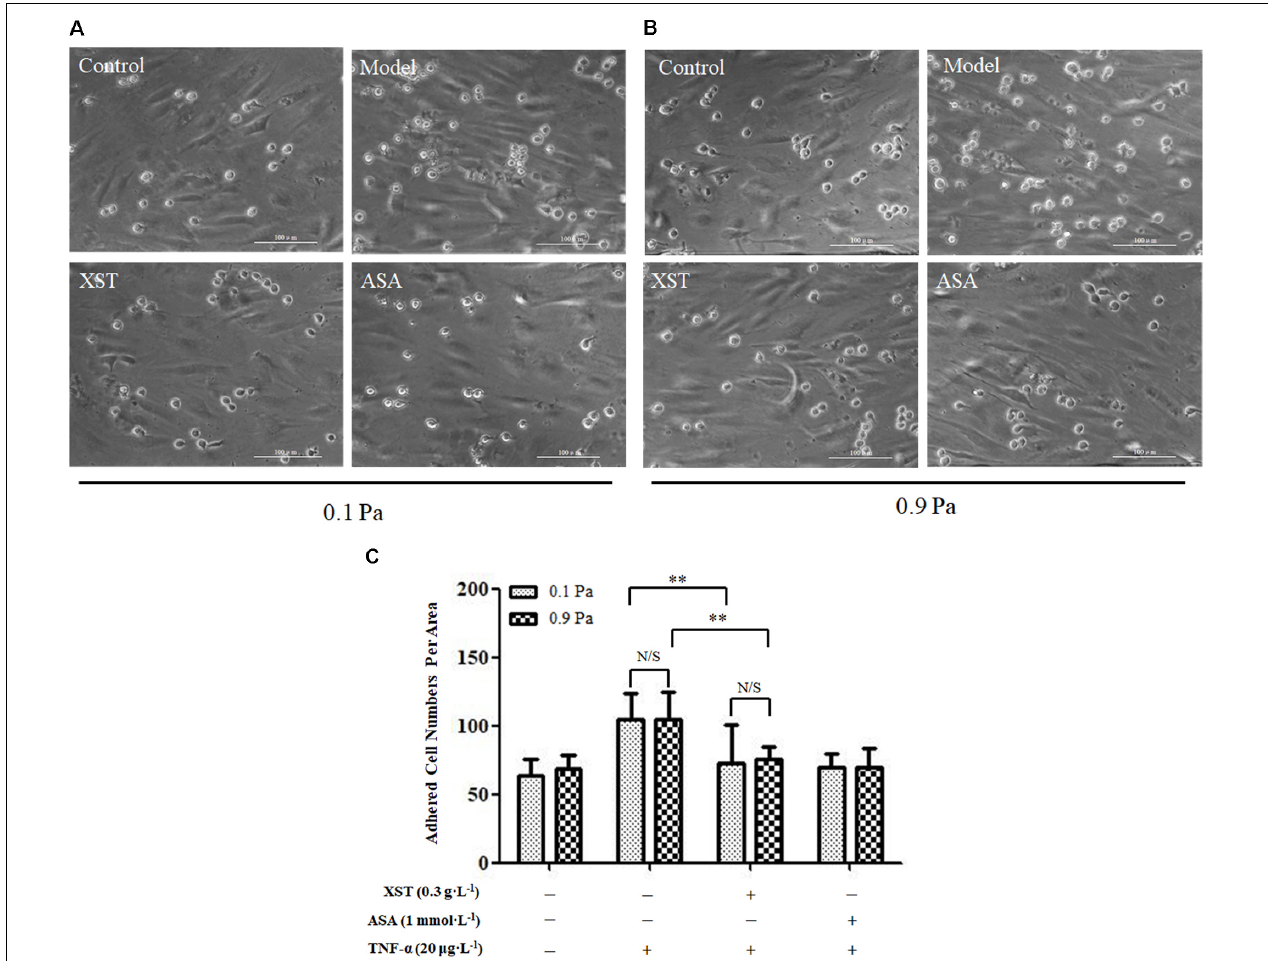
FIGURE 4 | Comparisons of THP-1 adhesion between groups. (A) under 0.1 Pa flow condition, and (B) under 0.9 Pa flow condition (magnification × 200). (C) Histogram demonstrating the THP-1 cells adherence on activated HUVECs under different flow conditions. The data was presented as means ± SD, n = 9; data was analyzed by two-way ANOVA as described in Methods; analysis of simple effects. ∗∗ P <